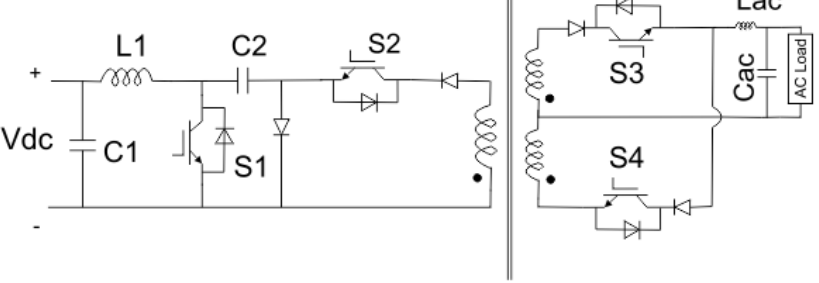
Figure 8. Single-phase PWM voltage source rectifier.